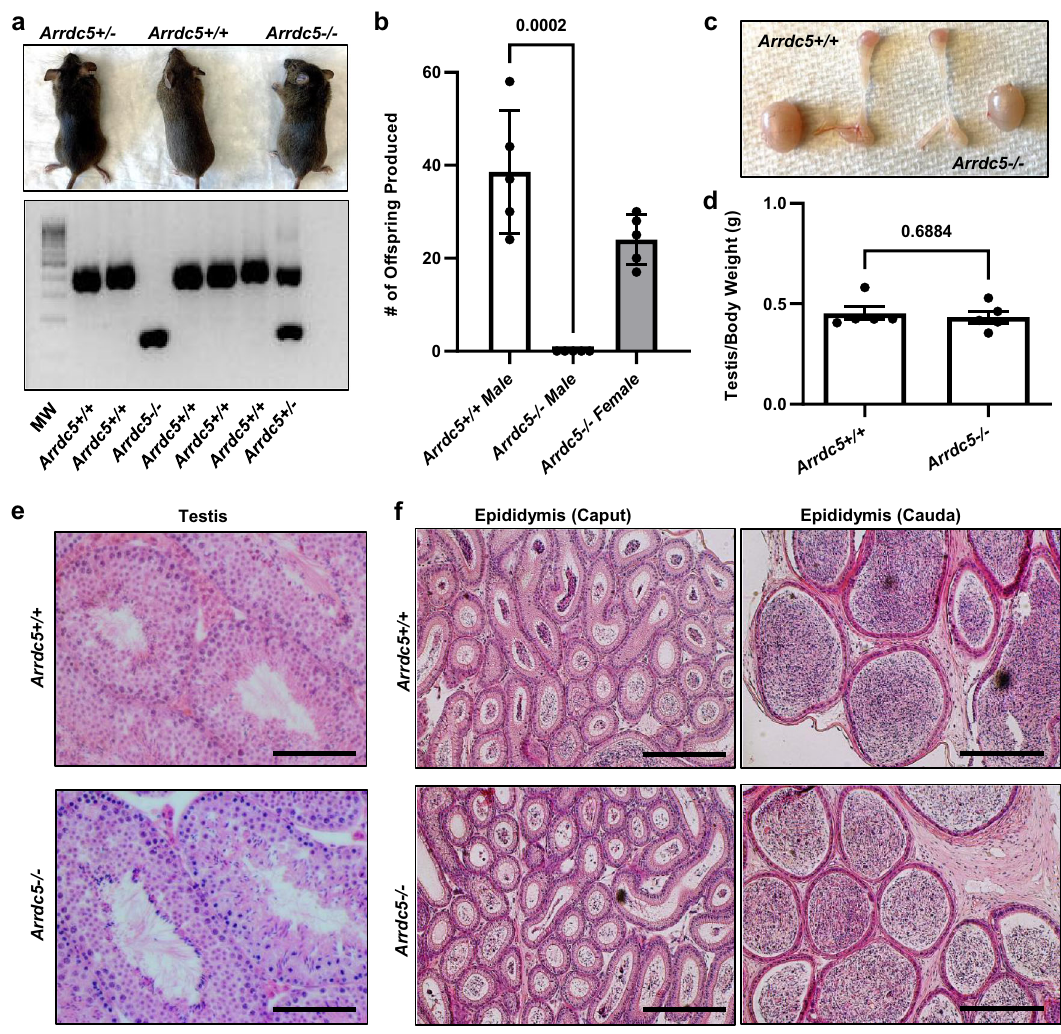
Fig. 3 | Impact of Arrdc5 genetic inactivation in mice. a Male mice heterozygous ( +/ − ),homozygous( − / − ),ornon-possessing( +/+ )ofaninactivating308bpdeletion allele for the Arrdc5 coding sequence, and an agarose gel for visualization of genomic DNA genotyping analysis. MW is a 100bp DNA ladder. b Quantitation of fecundity for adult Arrdc5 − / − male and female mice as well as control Arrdc5 + /+ male littermates over a 4-month period of pairing with wild-type female or male mice. Data bars are mean±SEM of the total numbers of pups born and dots represent values for individual animals ( n =5 for each genotype). c Testes and epididymis from adult Arrdc5 − / − and Arrdc5 + /+ littermates. d Quantitation of the